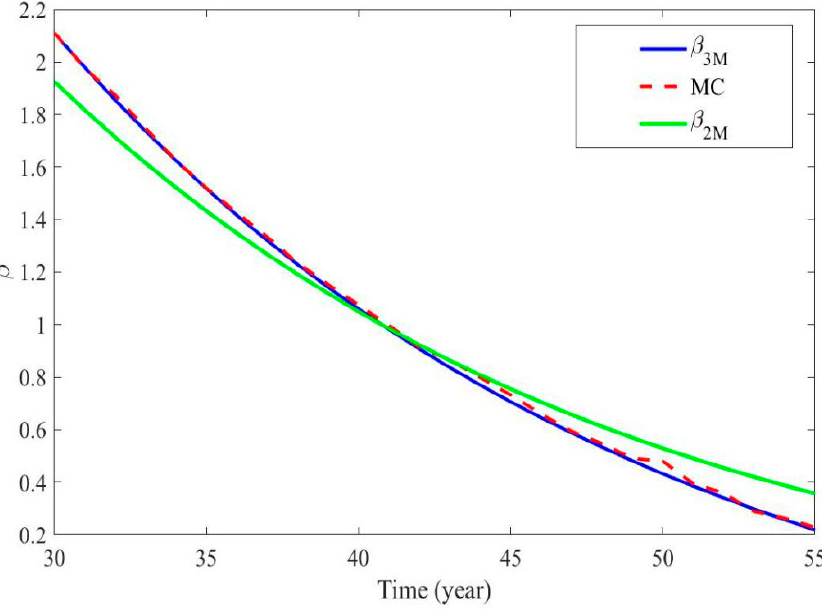
f ). Figure 15. Time-varying failure probability and MC simulation ( f c = 18.0 N/mm 2 ). c